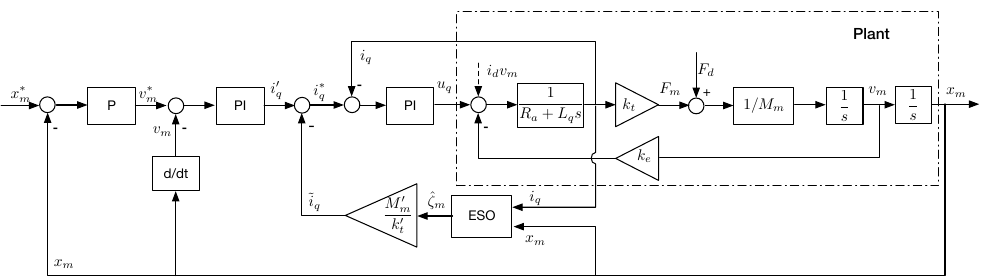
Figure 7. Block diagram of the cascaded PI controller and plant.